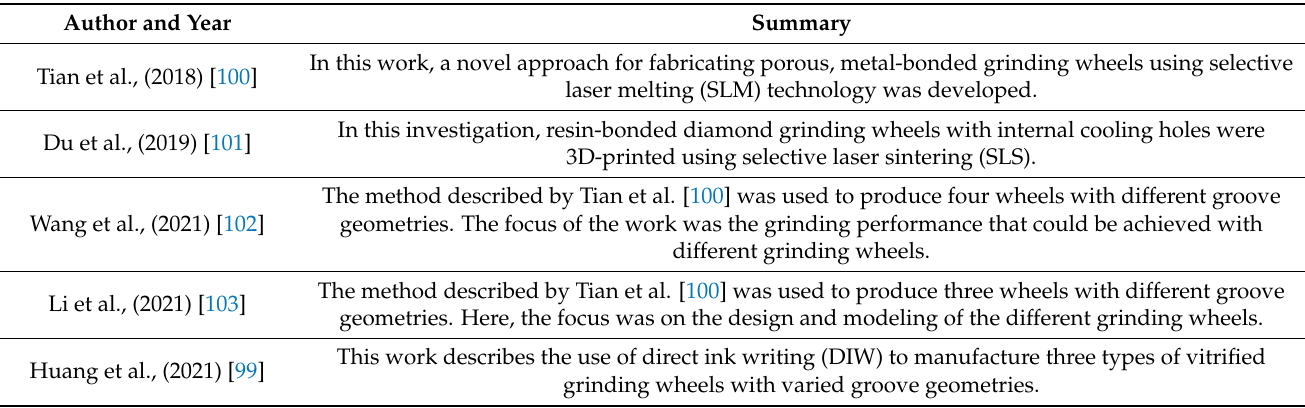
Table 7. Summary of publications on 3D printed